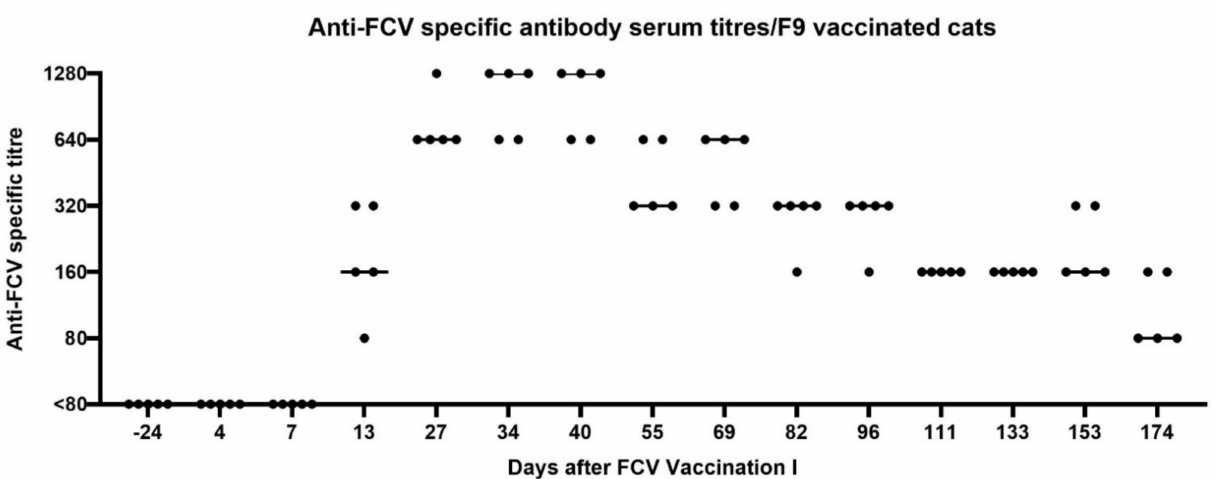
Figure 1. Dot plot of anti-FCV specific antibody serum titres of the five vaccinated cats measured by immunofluorescence assay (IFA) before and after FCV Vaccination I with FCV F9. Each dot represents the titre of a cat of the vaccine group. The horizontal bar represents the median. The second injection of FCV Vaccination I was performed at day 21 after the first injection. Antibody titres reflect the reciprocal of the last serum dilution showing positive fluorescence in the IFA. Days are indicated as days after the first injection of FCV Vaccination I.